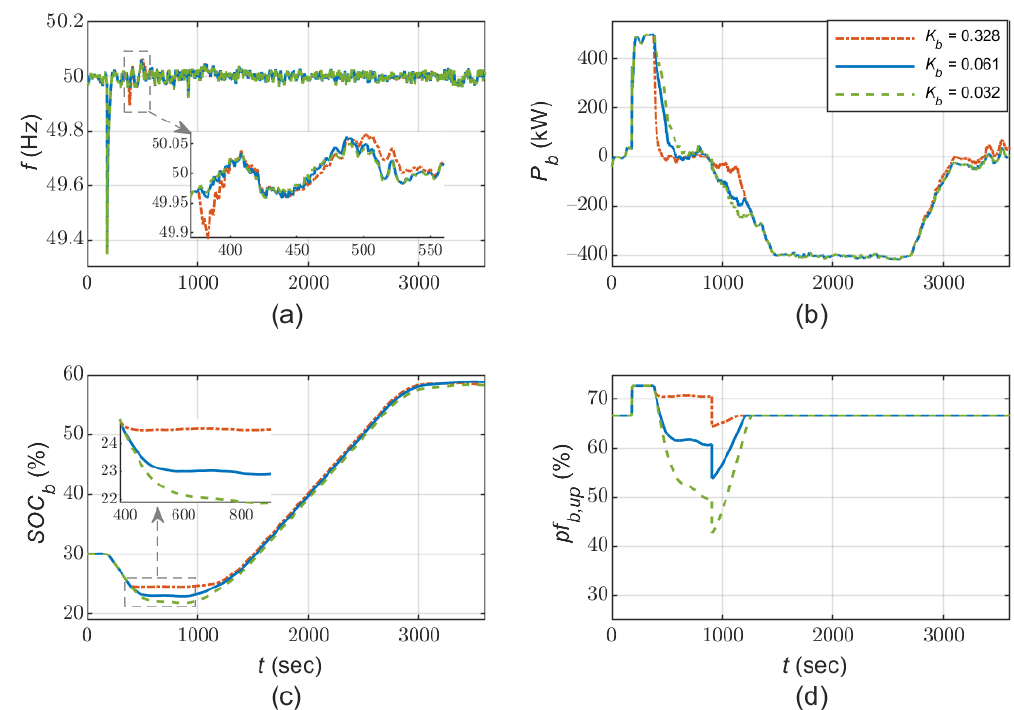
Figure 11. Response following a diesel unit outage at 150 s and synchronization of another at 900 s, for different K b values. ( a ) Frequency, ( b ) BESS active output power (positive: injection, negative: absorption), ( c ) SOC, ( d ) BESS aFRR-up participation factor.